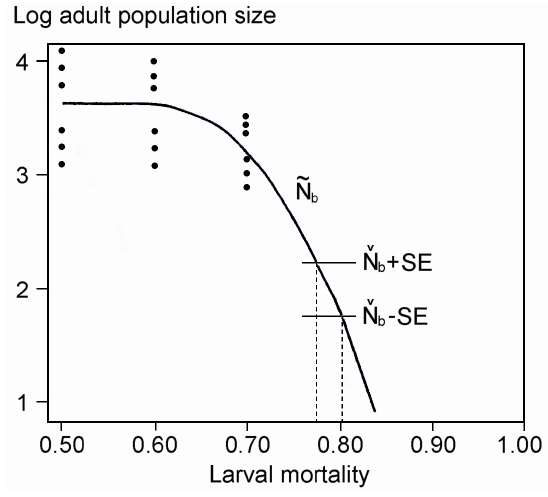
Figure 3. Population size development in a hypothetical population of Chioglossa lusitanica as a function of adult mortality ( q b , vertical axis) and larval mortality ( q l , horizontal axis) modeled with Vortex. The curved line indicates parameter combinations at which population size is stable ( r stoch = r = 0 [31]). Higher and lower q -values result in declining and increasing population sizes, respectively. The situation in which adult mortality is higher than larval mortality (parameter space shaded, q b > q l ) is considered unrealistic. For details see text and Appendix 3. Round symbols refer to parameter combinations determined for Poço do Inferno where population size is increasing and square symbols refer to parameter combinations determined for the declining Ribeira de Silveirinhos population (symbols as in Figure 2).